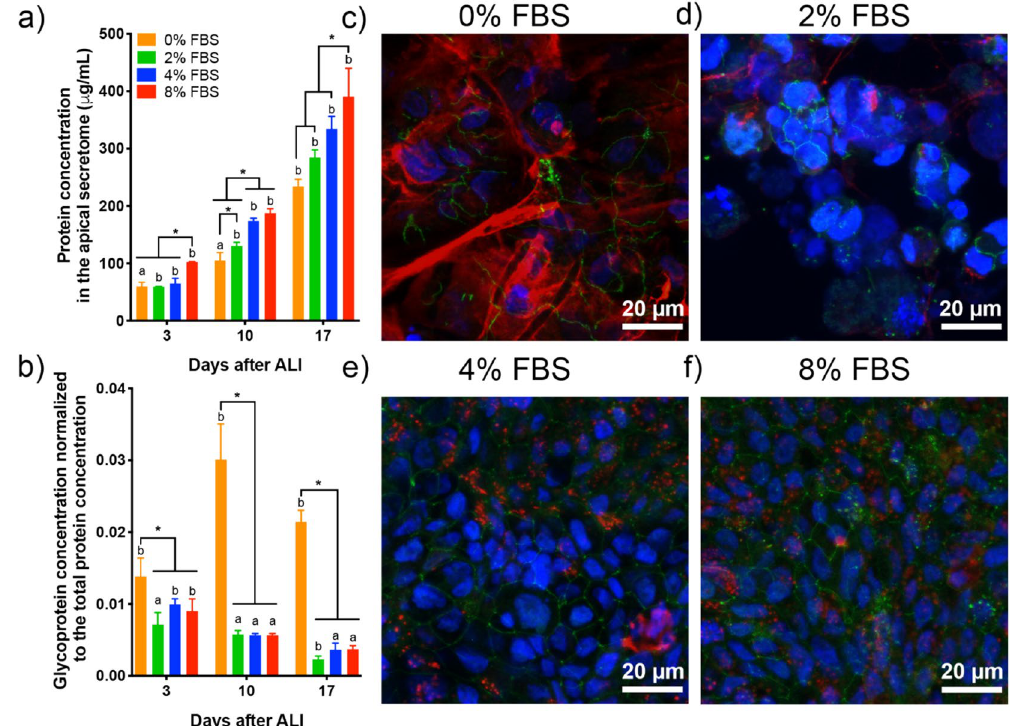
Figure 2. Effect of lower FBS supplementation on the apical secretion by Calu-3 cells in long-term cultures. ( a ) Total protein and ( b ) glycoprotein concentration in the apical secretome of Calu-3 cells supplemented with 0, 2, 4, 8% FBS at day 3, 10 and 17 after ALI. The glycoprotein concentration was normalized to the total protein concentration. ( c – f ) Immunolabelling of ZO-1 (green) and MUC5AC (red) in DAPI-stained Calu-3 cells at day 17 after ALI. The cell cultures were supplemented with 0 ( c ), 2 ( d ), 4 ( e ), and 8% FBS. Each image is the z-projection of 10 slides. (n = 3) *P < 0.01 a,b statistically different between